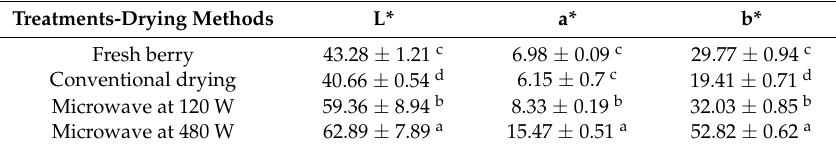
Table 3. Colour of dry Physalis